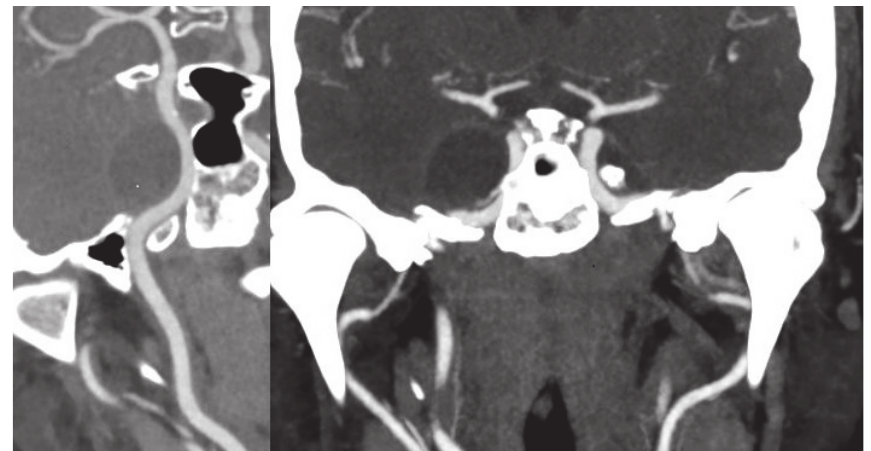
Figure 2: The CT angiography shows that the tumour is adjacent to the wall of the right internal carotid artery.